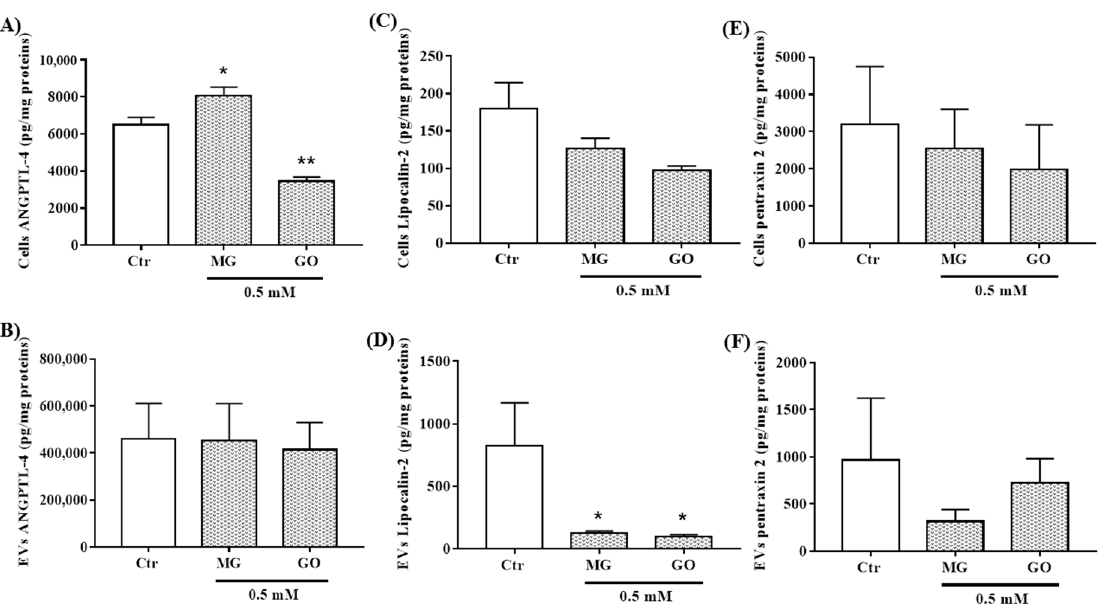
Figure 7. ANGPTL-4, LCN2 and PTX2 levels in nEVs and in SK-N-SH cells exposed or not to MG and GO. The level of each marker was normalized using total protein concentration. The bar graphs show ANGPTL-4 , LCN2 and PTX2 levels in SK-N-SH cells ( A , C , E ) and in nEVs ( B , D , F ). Values are mean ± S.E.M (from three separate experiments) and data groups were compared with one-way ANOVA followed by the Dunnett’s post hoc test. * p < 0.05, ** p < 0.01 versus controls cells.